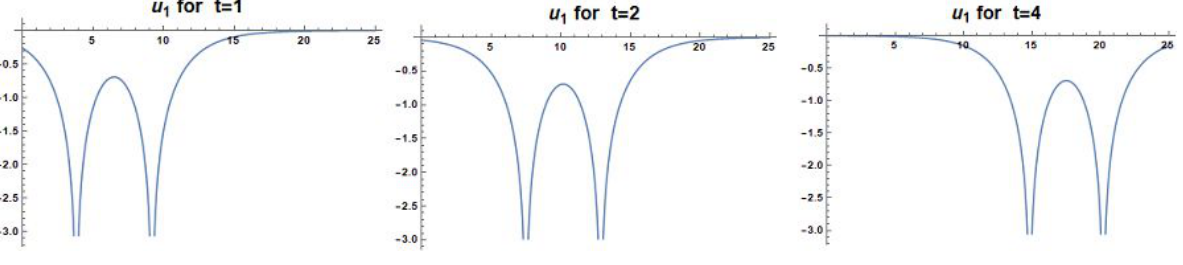
Figure 6: Simulation graphics for A = 1, µ = −4, λ = 1, w = 1.8 values of Eq.